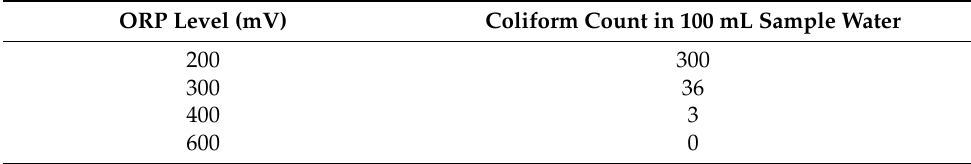
Table 6. ORP-levels versus Coliform bacteria [85].